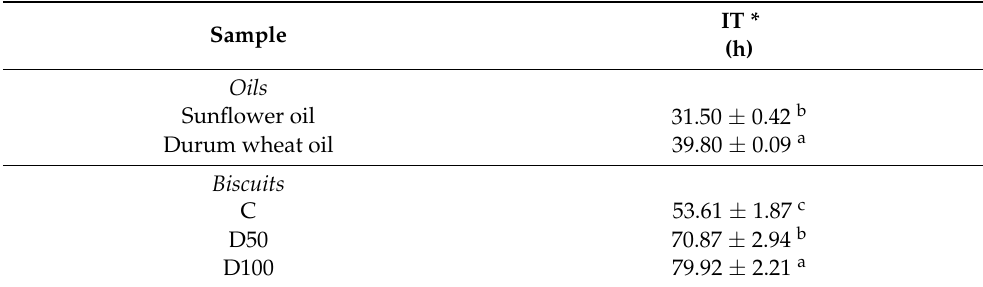
Table 4. Resistance to oxidation of the oils and biscuits. C = Biscuits prepared with 100% sunflower oil; D50 = biscuits prepared with sunflower oil (50%) and durum wheat oil (50%); D100 = biscuits prepared with 100% durum wheat